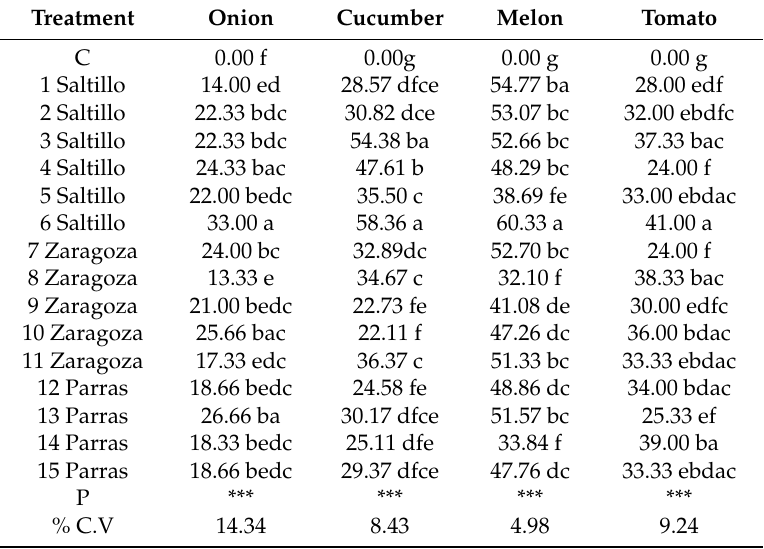
Table 4. Average mycorrhizal colonization (Tukey, p ≤ 0.05) in four horticultural species.